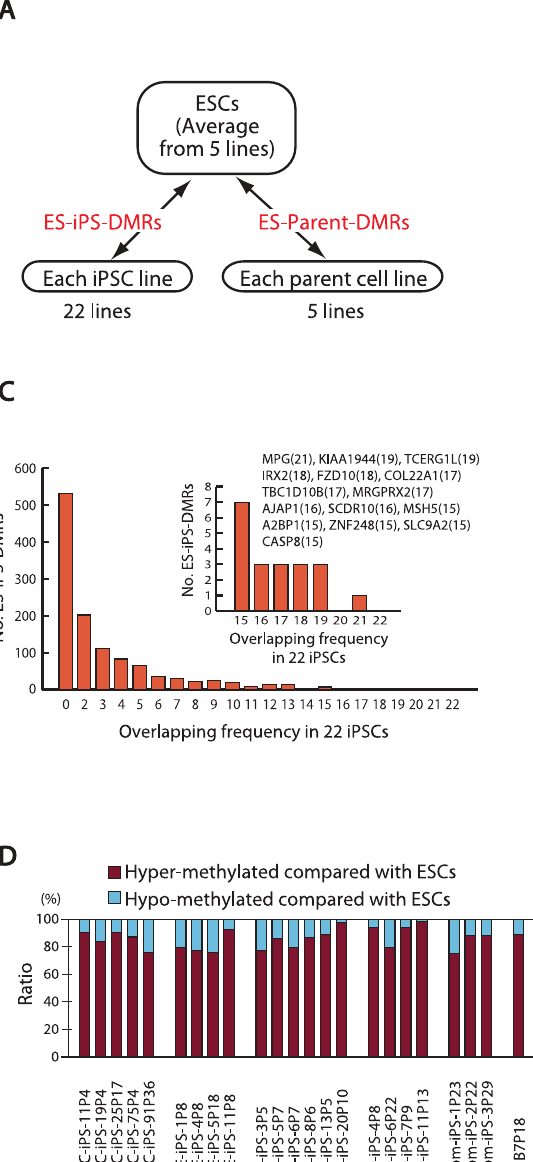
lower panels). Positive and negative difference values indicate that these sites are hyper- and hypo-methylated, respectively, when compared with ESCs. Difference values of the ES-iPS-DMRs showing aberrant methylation states in iPSCs at the early passage approached zero with passaging. It should be noted that the almost all difference values became largely positive in iPSCs at